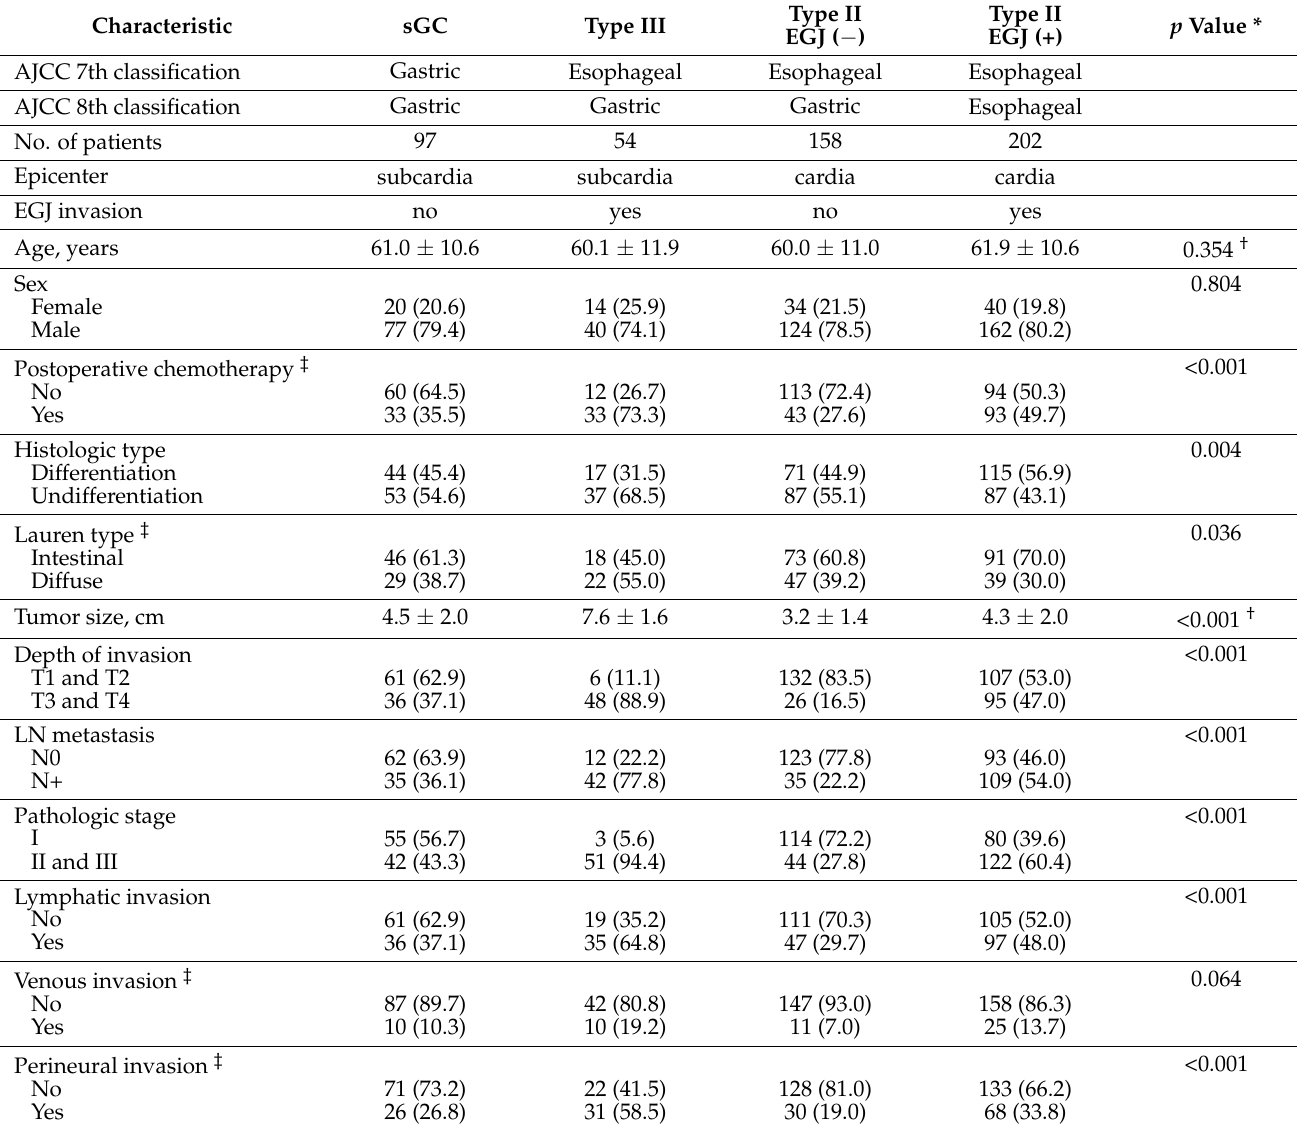
Table 1. Clinicopathologic characteristics of patients diagnosed with cardia or subcardia cancer categorized according to location of the epicenter and invasion of the esophagogastric